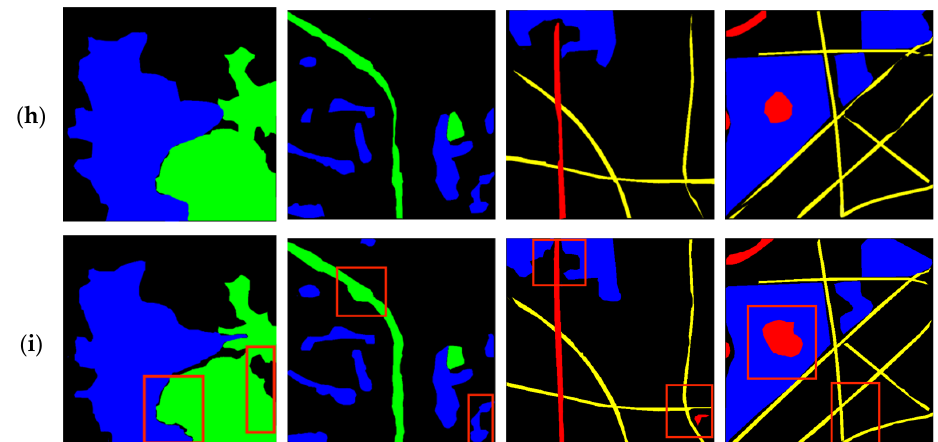
Figure 10. Model prediction results: ( a ) SAR image, ( b ) optical image, ( c ) label image, ( d ) adaptive threshold results, ( e ) OSTU results, ( f ) FCN network results, ( g ) PSPNet network results, ( h ) Deeplabv3+ network results, ( i ) method results in this paper.